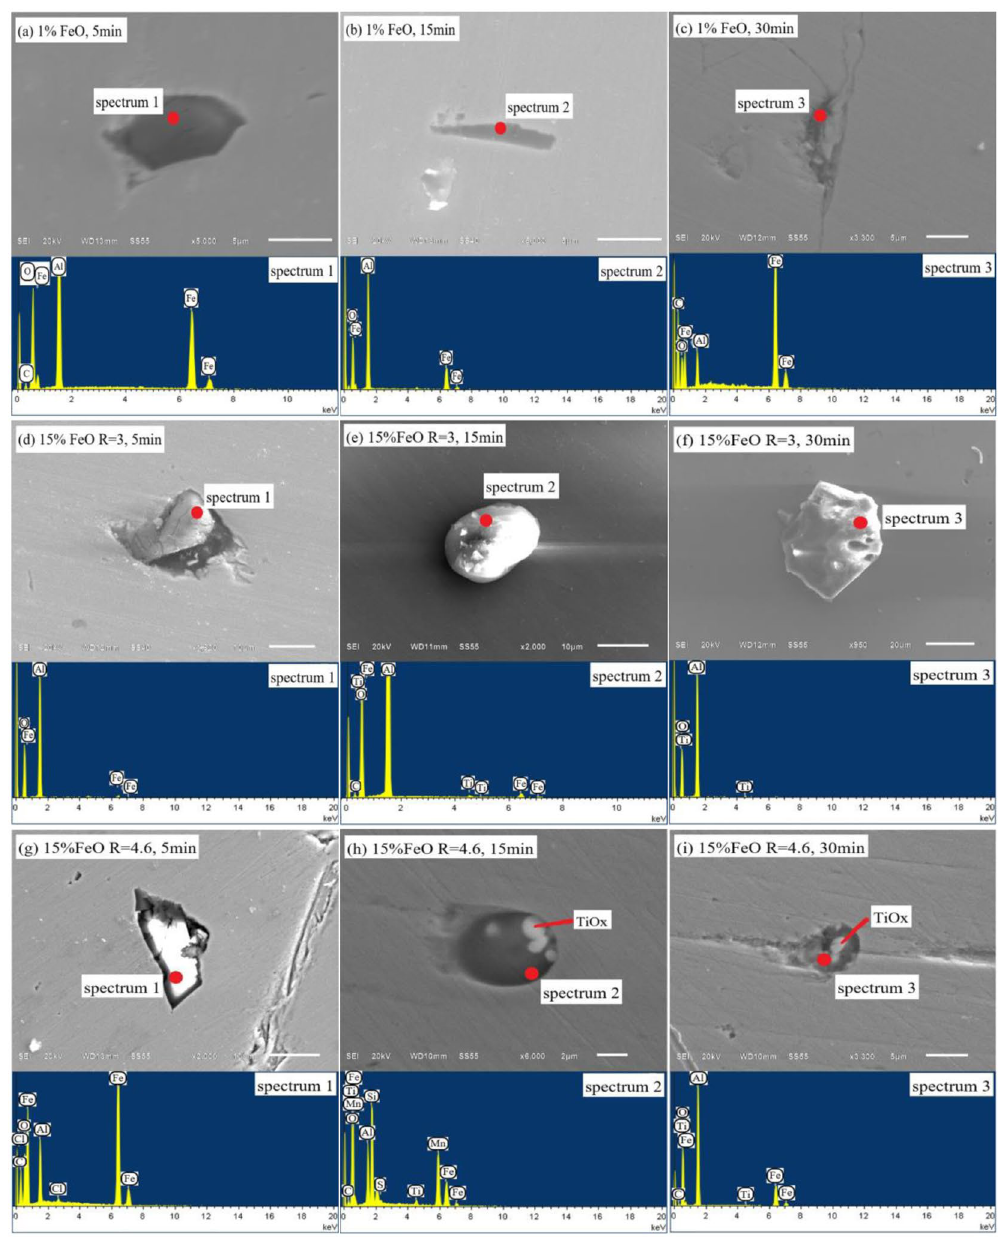
Figure 8. Evolution of inclusions in ultra-low carbon steel sample by experimental: ( a–c ), w (FeO)% = 1%; ( d–f ), w (FeO)% = 15%, R = 3; ( g–i ), w (FeO)% = 15%, R =